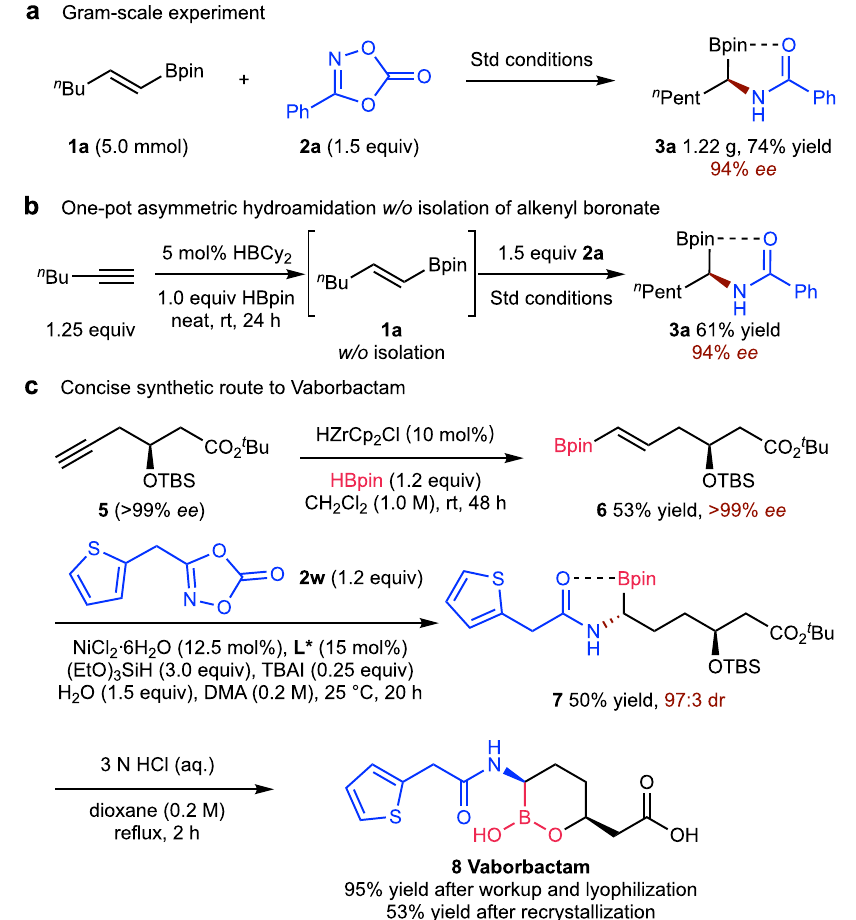
Fig.5|Gram-scaleexperimentandsyntheticapplication.a Gram-scaleexperiment. b One-potasymmetrichydroamidationw/oisolationofalkenylboronate. c Concise synthetic route to